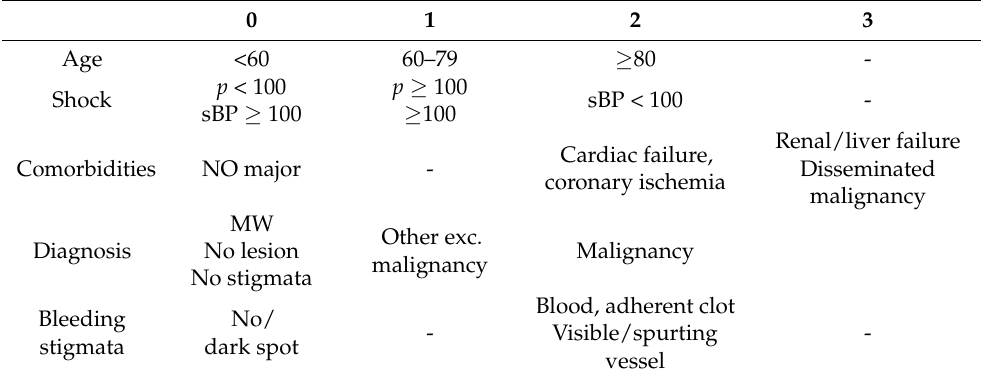
Table 1. Rockall score [3].